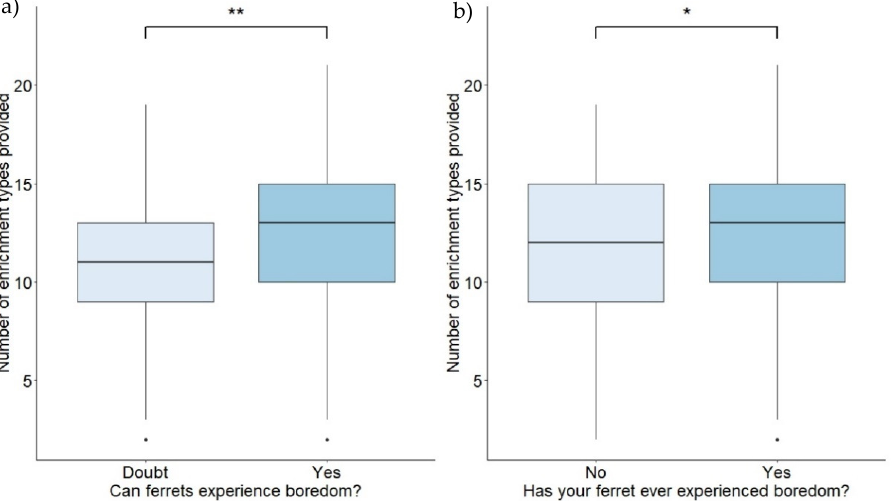
Figure 1. The number of environmental enrichment types provided by respondents who ( a ) expressed doubt as to whether ferrets can experience boredom, and those who believed ferrets can experience boredom, and ( b ) respondents who did not think their own pet ferrets had ever experienced boredom, and those who thought their pet ferrets had experienced boredom. * indicates a p value of less than 0.050, ** indicates a p value of less than